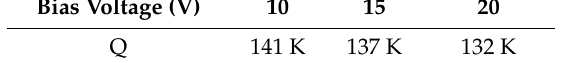
Table 6. Q of the DRG 5 with different bias voltages.